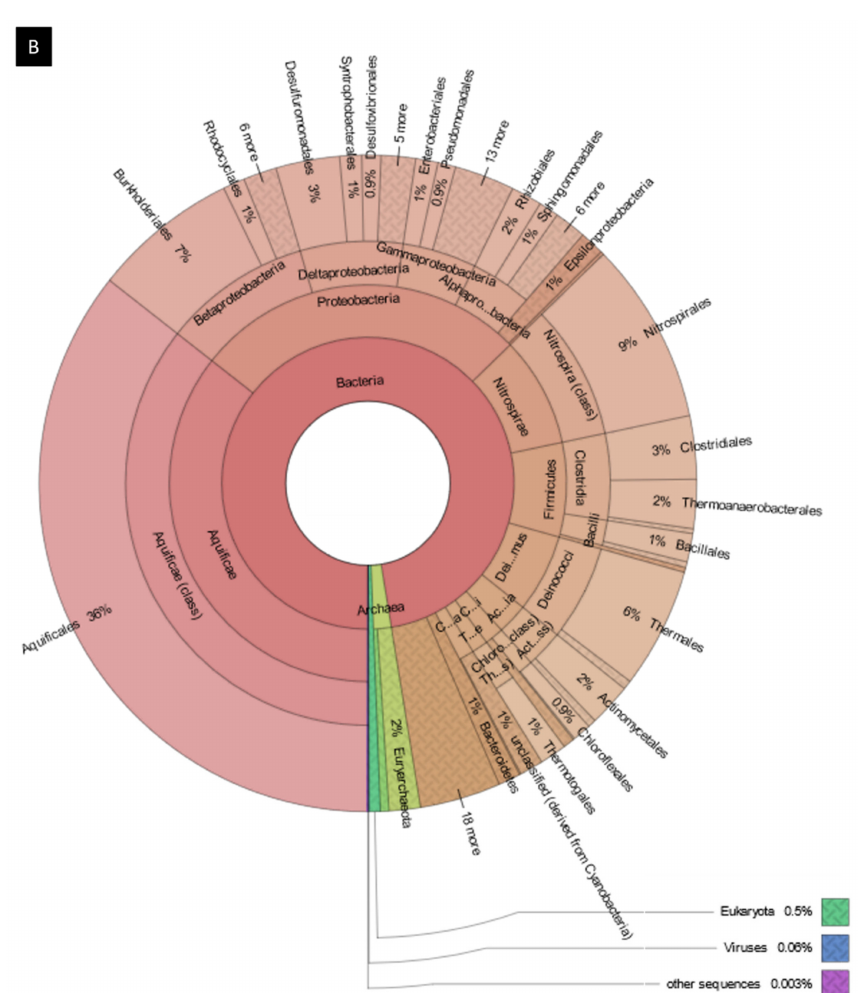
Figure 3. Results of the taxonomic read assessment for the Muiño da Veiga metagenome. ( A ) Rank of the top 14 most abundant genus in the metagenome, accounting for 56.2% of the total reads. The Y-axis represents in logarithm scale the number of reads for each genus. The genus outside this ranking accounted individually for less than 0.75% of the total reads, whereas the most abundant genus ( Sulfurihydrogenibium ) accounted for 19.3% of the total reads by itself, and the 8 most abundant genus accounted for more than half of the total reads. All the top-ranking genus belonged to the Bacteria domain. ( B ) Krona pie-chart representation of the taxonomical read assignments at the order level. Aquificales was the most abundant order with 36% of the reads, followed by Nitrospirales with 9% of the reads and Burkholderiales with 7%. Bacteria was the dominant domain with 97% of the reads, Archaea represented only 2% of the reads and the remaining reads belonged to Eukaryota, viruses and unassigned